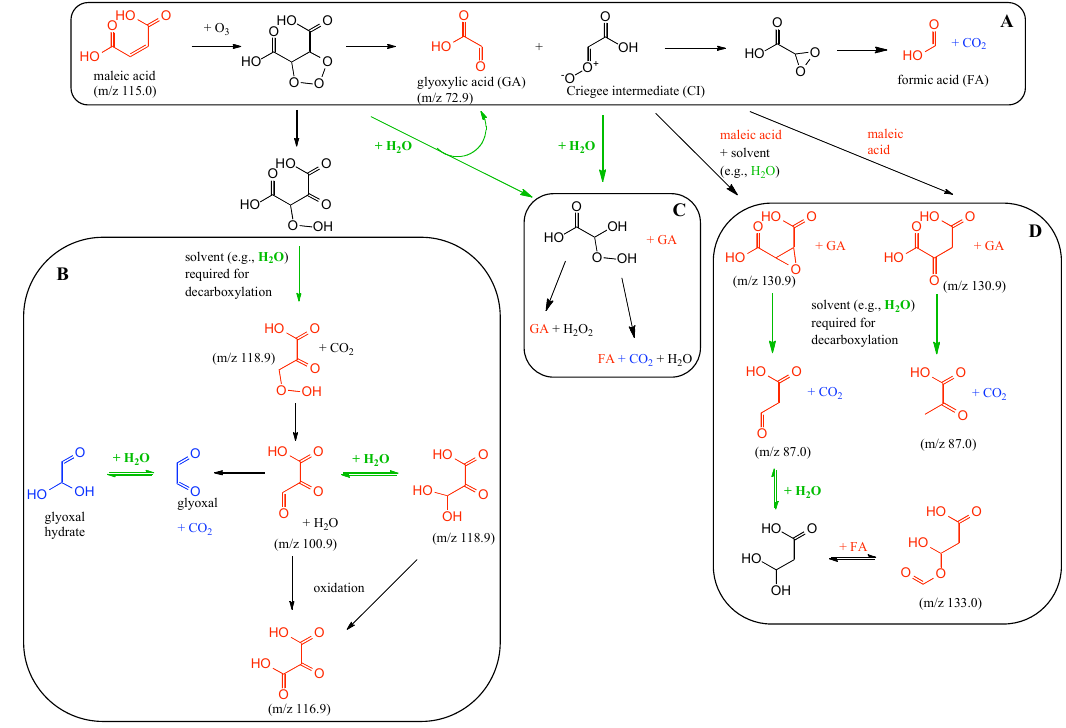
Figure 6. Fig. 6. Proposed mechanism for the reaction between ozone and maleic acid aerosol under dry and high RH conditions. Red: structures suggested for peaks observed in the mass spectra of this study, blue: observed by others, black: not observed, green: indicating reactions requiring